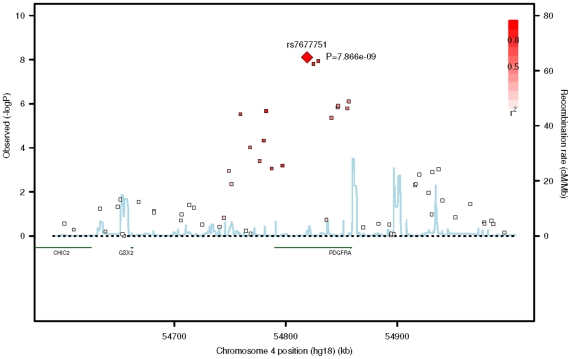
Regional plot of the association signals from the meta-analysis of the five GWAS cohorts around the PDGFRA gene locus.A region of 400 kb around the lead SNP (rs7677751, red diamond) is shown. The LD between the lead SNP and the neighbouring SNPs is represented by the shading of the squares, with increasing shade of red indicating higher LD as measured by r2. The blue lines represent the recombination rates of JPT+CHB panels from HapMap II.